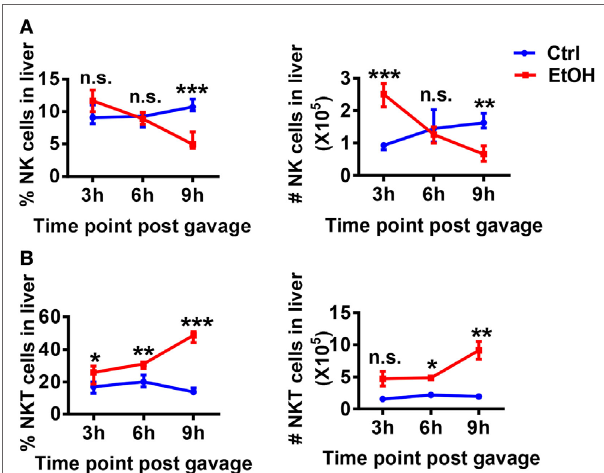
FigUre 5 | Hepatic natural killer (NK) and NKT cells display negatively correlated dynamics in the chronic-binge model. C57BL/6 mice were fed control or ethanol diets for 10 days plus one intragastric dose of EtOH (5 g/kg body weight) or isocaloric dextran-maltose, followed by euthanasia 3, 6, or 9 h after gavage. Liver mononuclear cells were isolated, and the percentages and absolute numbers of (a) CD3 − NK1.1 + NK cells and (B) CD3 + NK.1 + T cells among all leukocytes in liver were detected by flow cytometry and were statistically analyzed. The data are representative of more than three independent experiments and are shown as the mean ± SEM ( n = 3–6). * P < 0.05; ** P < 0.01; *** P < 0.005.